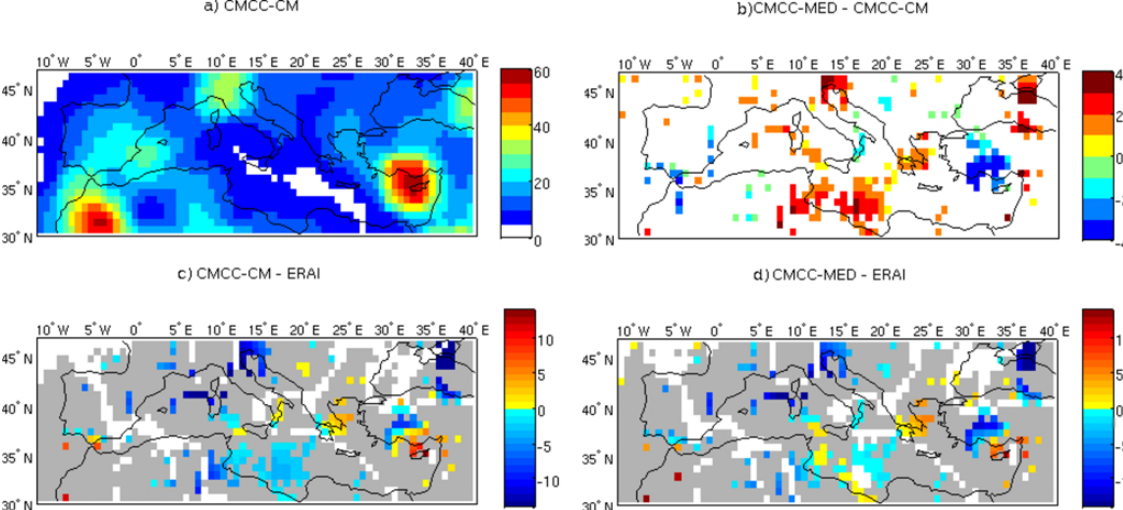
Fig. 2. Panel (a) : annual mean number of cyclogenesis events, tracked in CMCC-CM climatology. Panel (b) : difference (CMCC-MED minus CMCC-CM) in mean number of cyclogenesis events per year (reference period 1981–2010). Only statistically significant differences (KS test non-parametric, 90%) are shaded. Panel (c) : as panel (a) , but for differences between CMCC-CM and ERA-Interim. Panel (d) : as panel (a) , but for differences between CMCC-MED and ERA-Interim. In panels (c) and (d) , differences are shaded in grey, where the difference between CMCC MED and CMCC-CM is not significant (see panel a